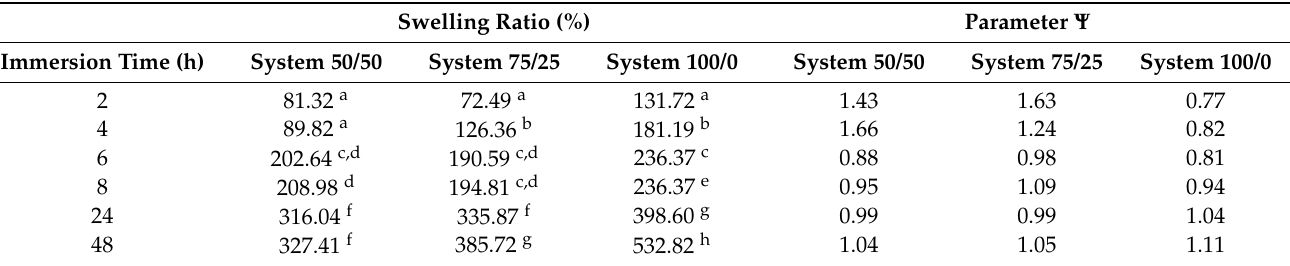
Table 1. Swelling kinetics for compression-molded porcine plasma protein (PPP)-based materials plasticized with glycerol (Gly) with different PPP/Gly ratios: 50/50, 75/25, and 100/0. Significant letters within a column indicates significant differences ( p <